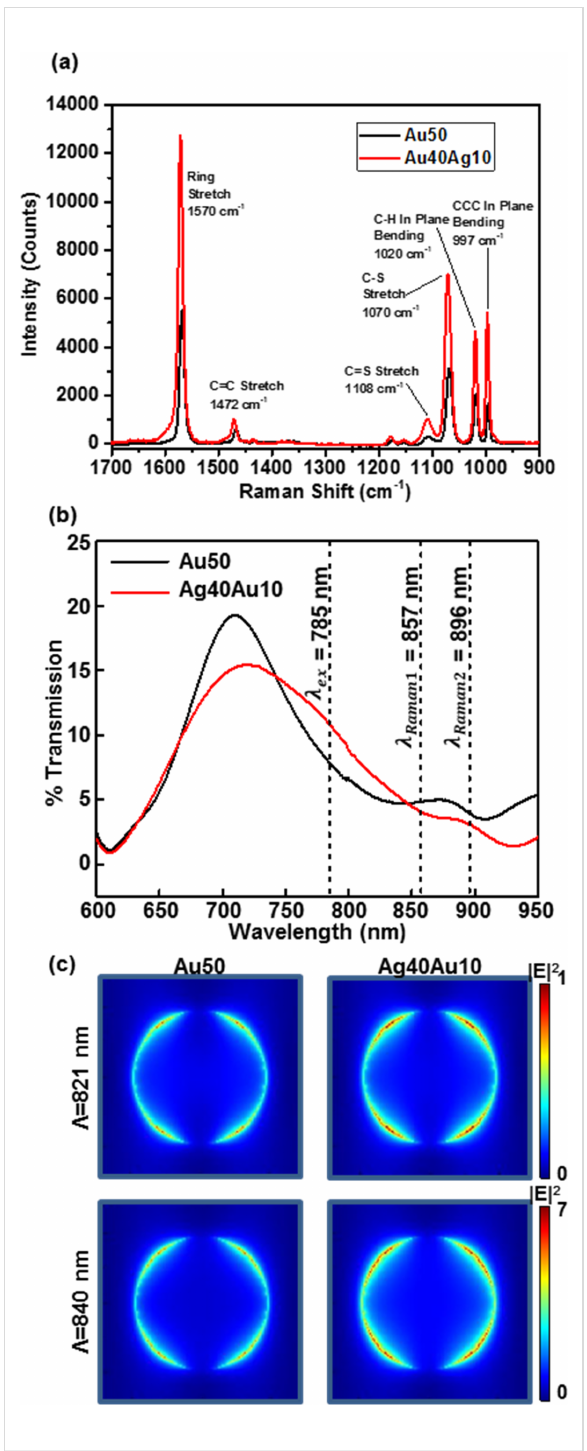
Figure 4: (a) SERS spectra of benzenethiol adsorbed onto Au50 and Ag40Au10 quasi-3D PCs measured with laser power of ≈ 5 mW. (b) Experimental transmission spectra in air for Au50 and Ag40Au10 quasi-3D PCs used to collect the Raman spectra in (a). The locations of the laser excitation and Raman peaks are marked as λ ex , λ Raman1 and λ Raman2 , respectively. (c) FDTD-computed top ( x – y ) intensity dis- tribution at 5 nm away from the surface of Au50 and Ag40Au10 quasi- 3D PCs at λ = 821 nm and 840